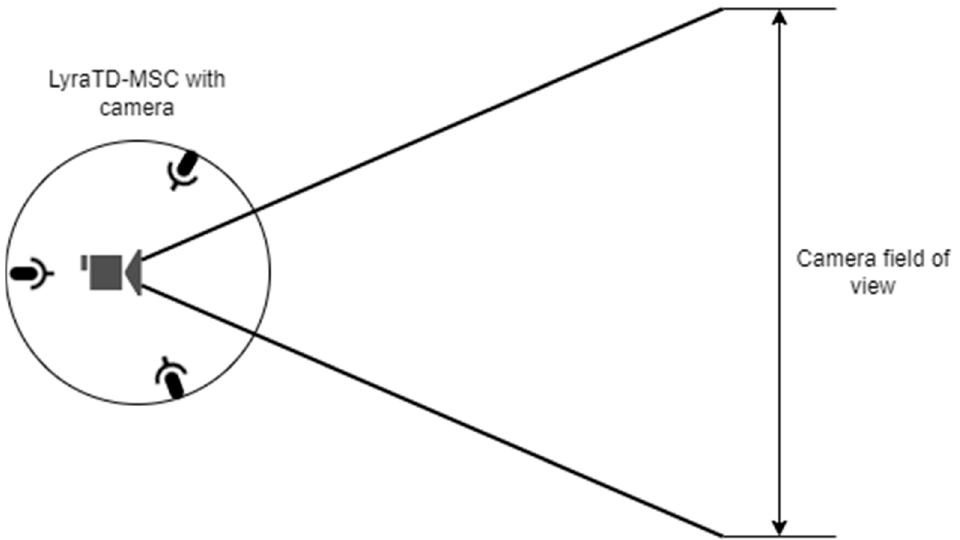
Figure 5. Position of the camera in relation to LyraTD-MSC.